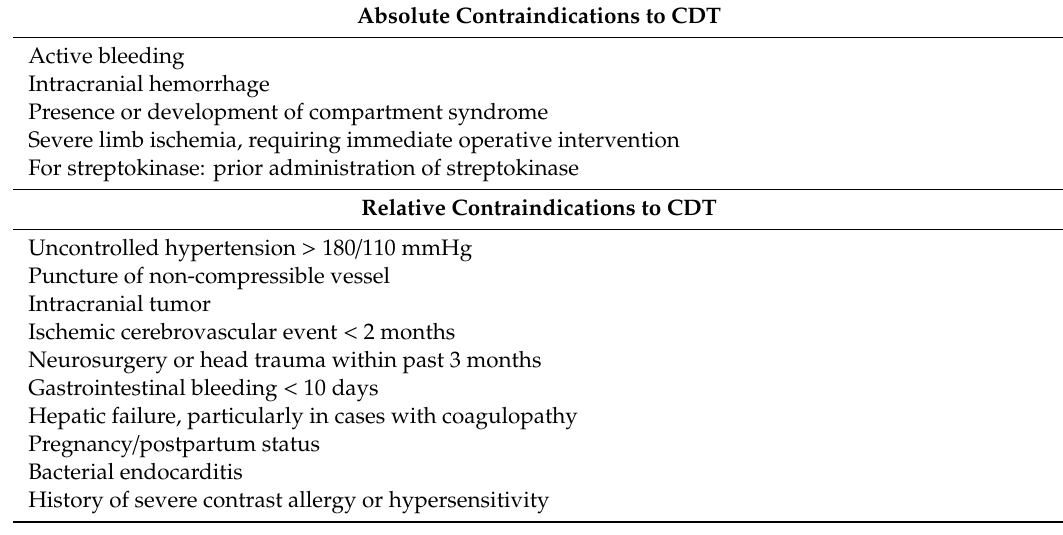
Table 3. Absolute and relative contraindications to catheter-directed thrombolysis (CDT) (modified after